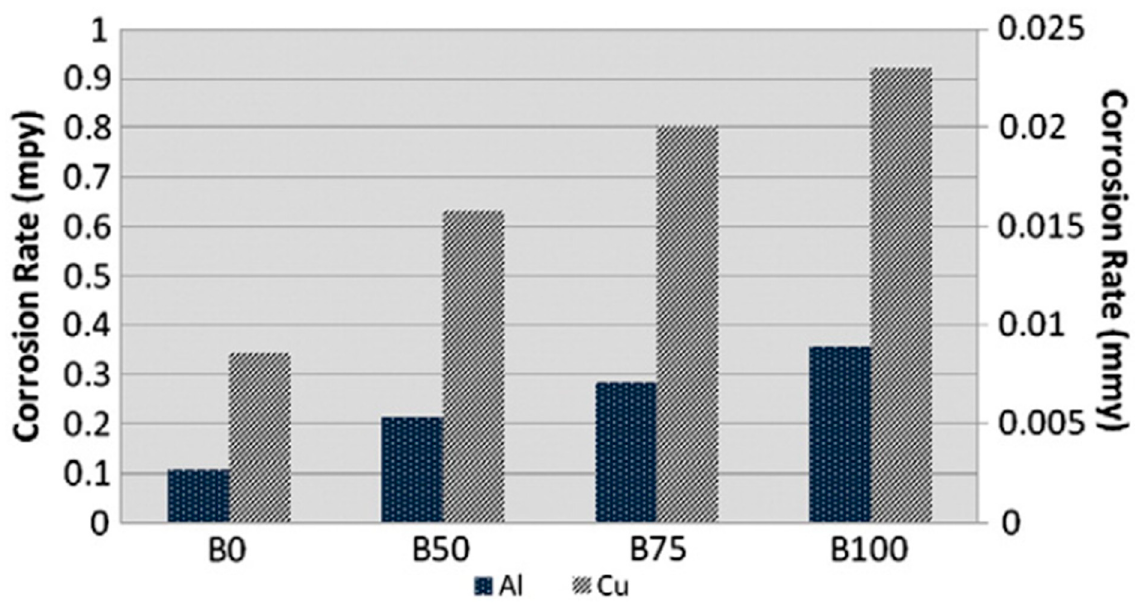
Figure 7. CRs of metals in diesel and biodiesel [71].